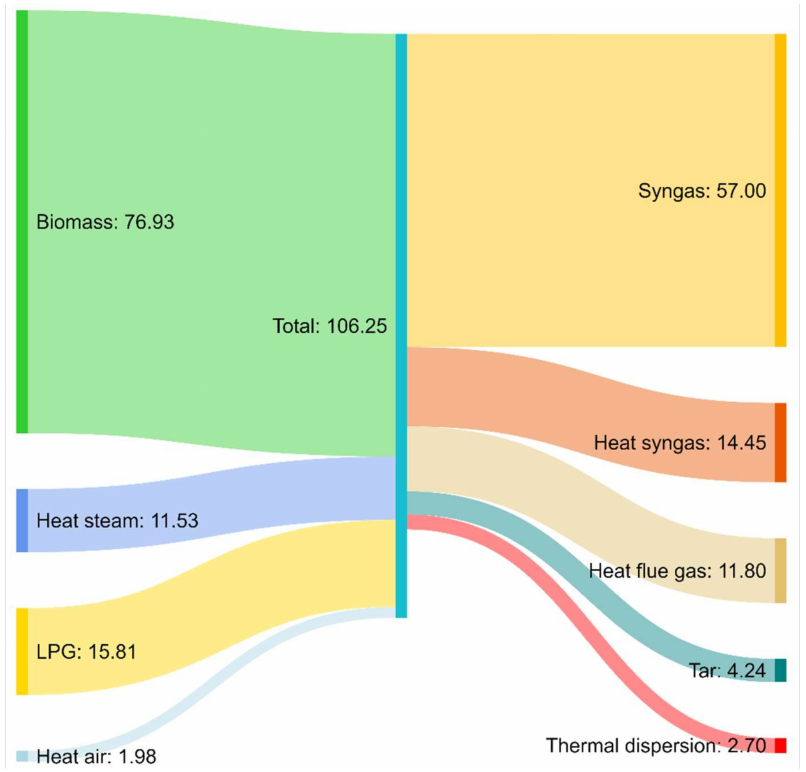
Figure 9. Dual-bed reactor energy balance (units in